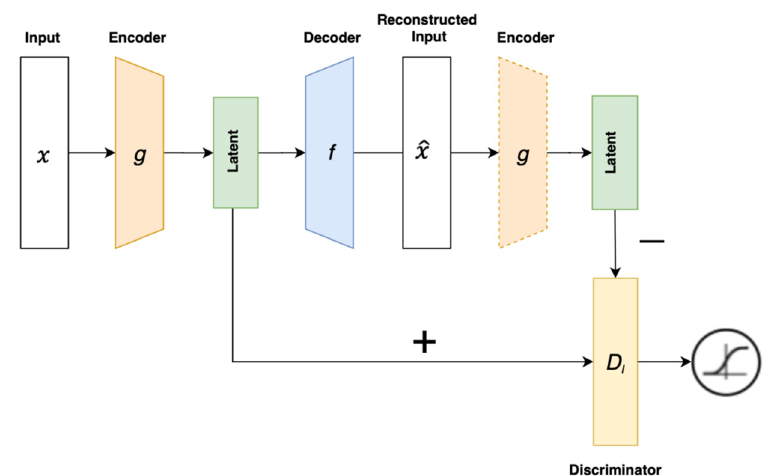
Figure 4. Architecture of the extended autoencoder, which is based on the autoencoder architecture with the addition of the discriminator D l . The dotted encoder is not updated during